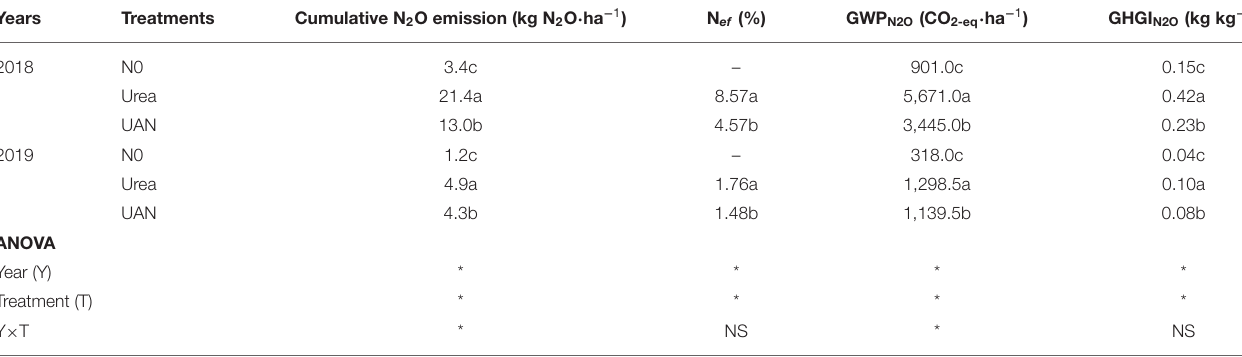
TABLE 5 | Effects of nitrogen fertilizer types on N 2 O emission, N 2 O emission coefficient, GWP, and